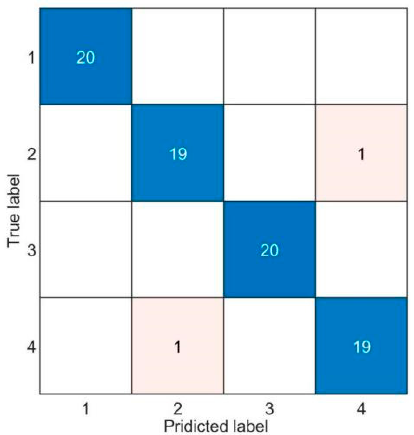
Figure 13. The confusion matrix of the WOA-VMD-PSO-SVM method.